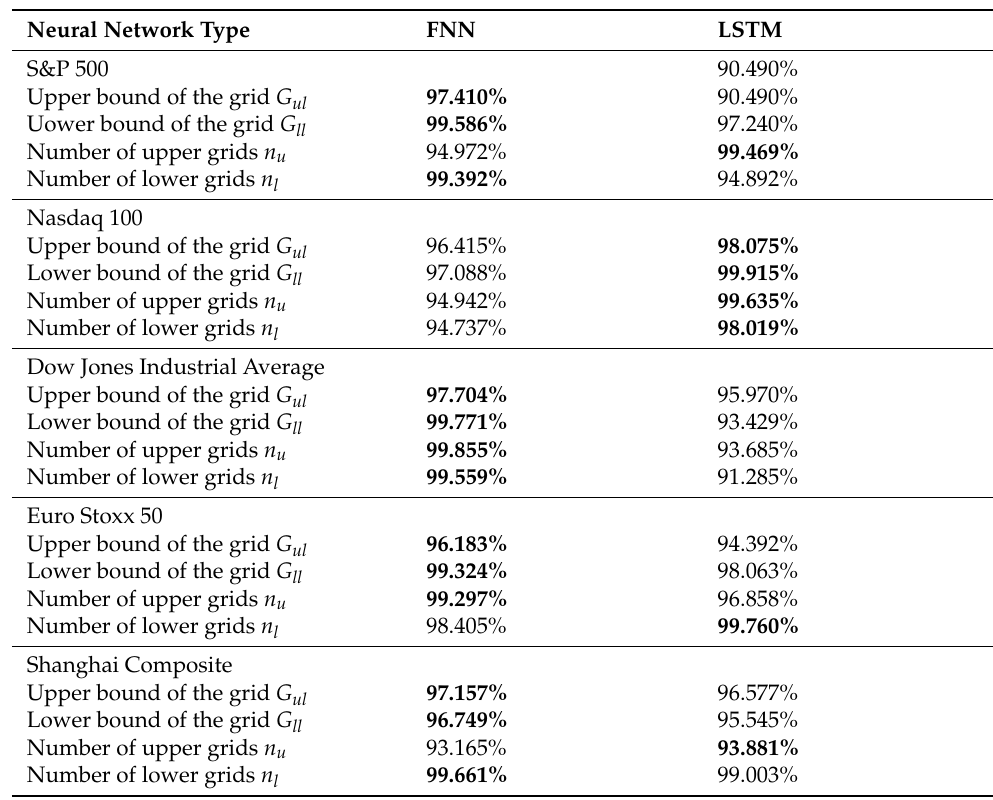
Table 15. Comparison of coefficient of determination between FNN and LSTM